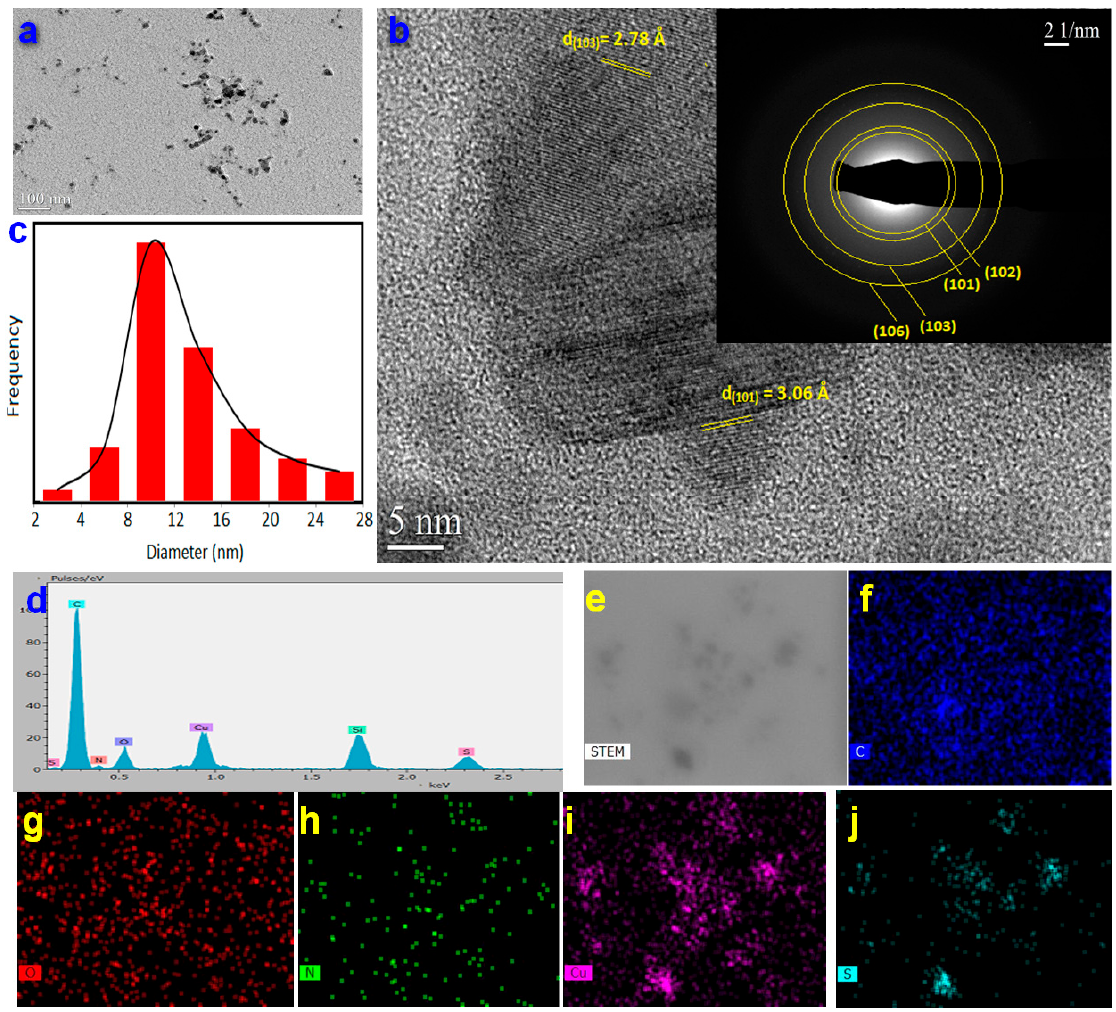
Figure 1. ( a ) TEM image; ( b ) HRTEM image and SAED pattern (inset b ); ( c ) particle size distribution; ( d ) EDX spectrum; ( e ) DF-STEM image; and elemental mapping for ( f ) carbon, ( g ) oxygen, ( h ) nitrogen, ( i ) copper, and ( j ) sulfur of CuS-BSA nanoparticles.